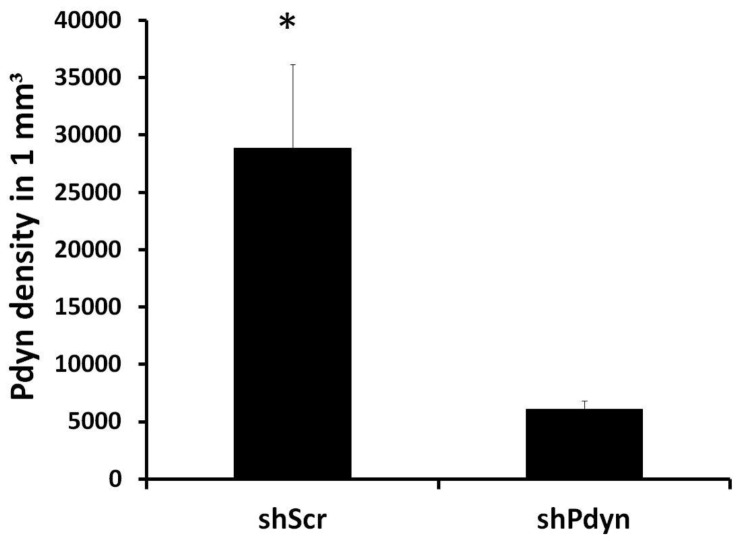
Efficacy of prodynorphin (Pdyn) knockdown procedure.The optical density of Pdyn signal within the area of GFP expression was divided by the measured area to obtain the density per 1 mm3. The viral vector expressing a shRNA sequence directed at Pdyn transcript (shPdyn) led to a significant reduction of Pdyn mRNA expression in the transduced region compared to the control shScr vector. N = 5–6, *p<0.001.